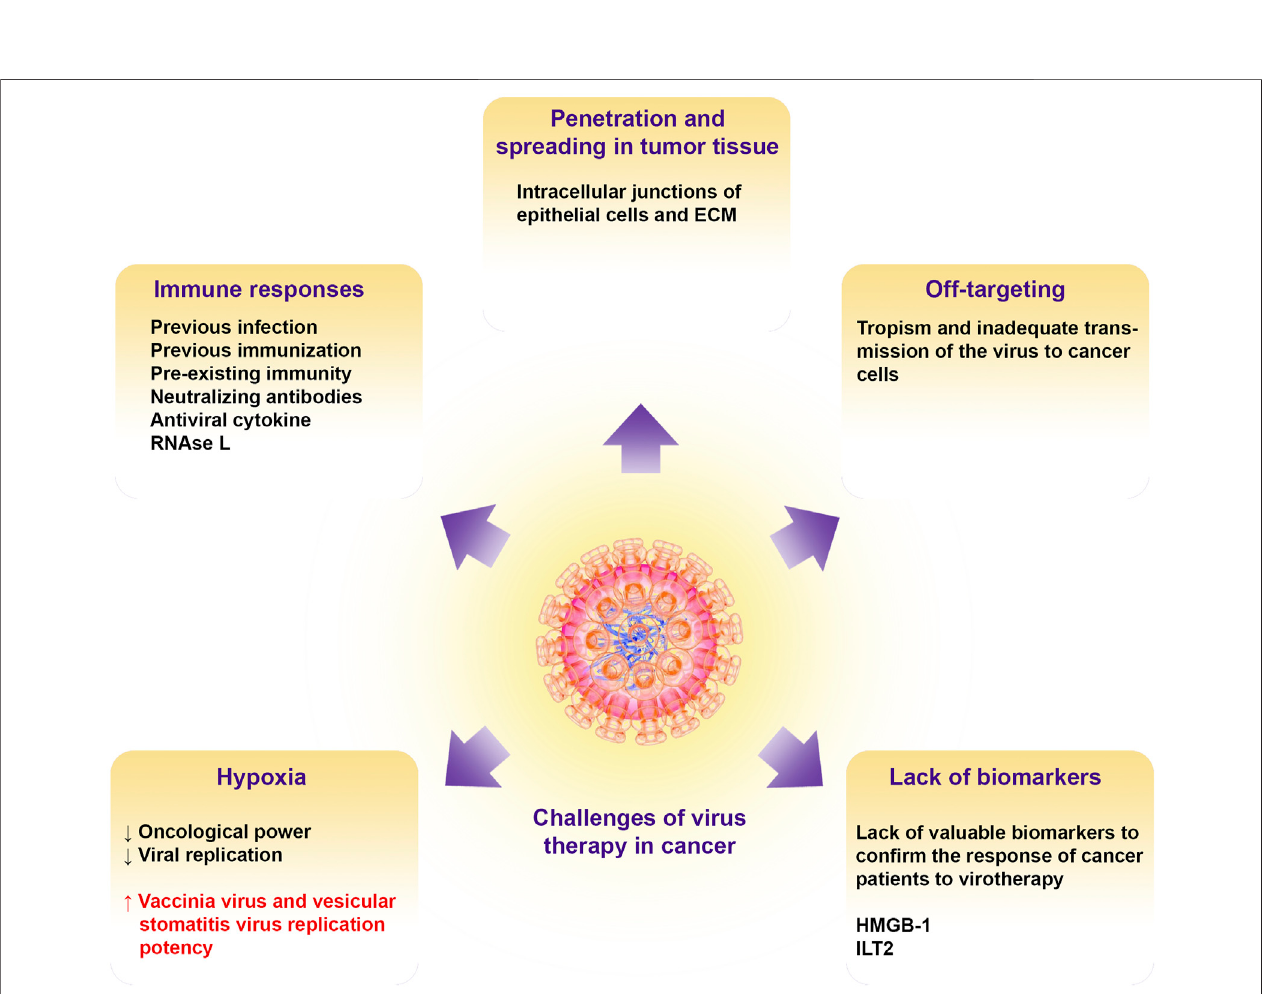
FIGURE 3 | Challenges of oncolytic virotherapy in cancer. Illustrate the barriers to oncolytic viral therapy including tissue penetration, off targeting, immune responses, hypoxic condition in the TME, and lack of putative biomarkers for patient virotherapy monitoring. ECM, extracellular matrix; HMGB-1, high mobility group box-1; ILT2, Ig-like transcript